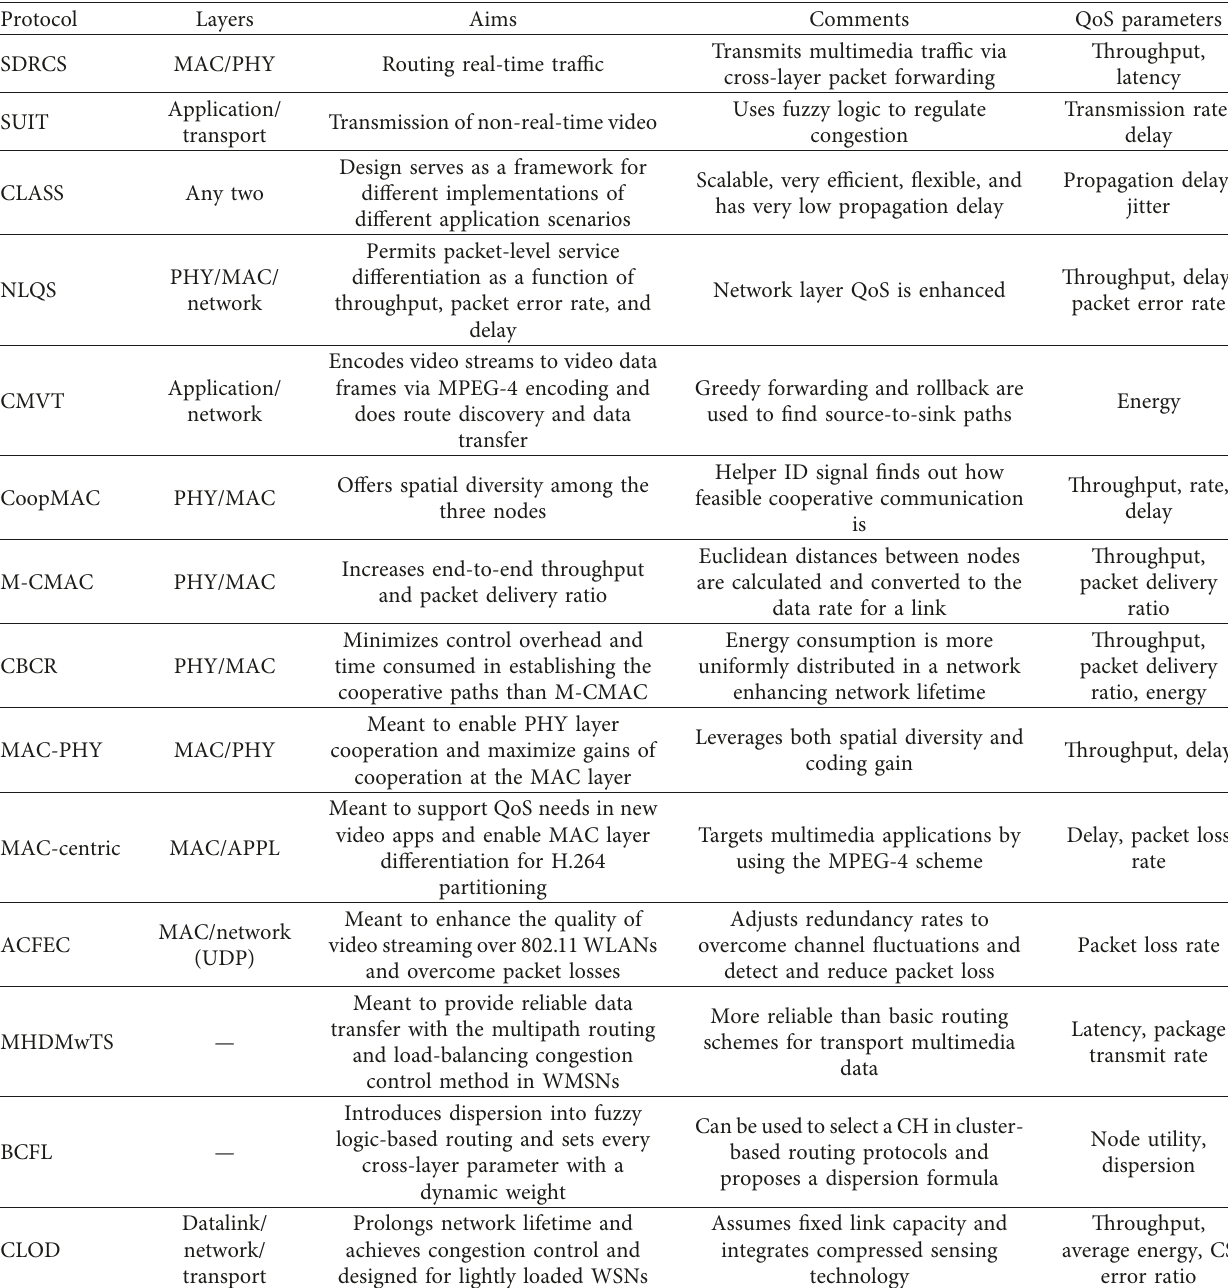
Table 4: A summary of some of the reviewed cross-layer